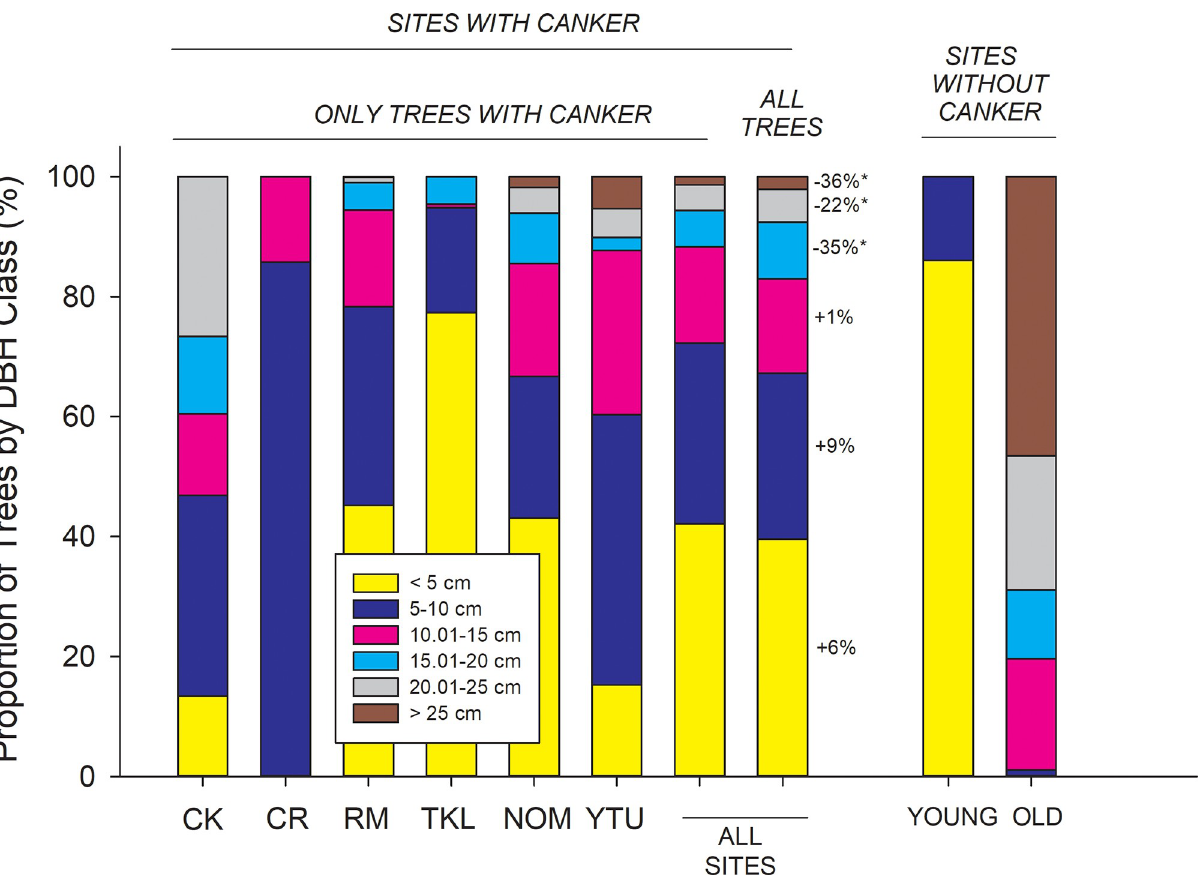
Fig 5. Proportion of DBH size classes at 72 sites with canker (columns 1–8) and at 16 sites without canker (columns 9–10). For sites with canker, the first 6 columns show data for only trees with canker categorized by ecoregion, and column 7 shows the mean across all sites for trees with canker. Column 8 shows the size distribution of all trees (with and without canker) at sites where canker was present. Values beside size classes in Column 8 refer to the % increase in proportion of infected trees vs. the population as a whole for each size class ( � P < 0.10). For example, there are 6% more trees infected with canker in DBH class 1 than there are in the population (NS), while there are 35% fewer trees infected with canker in 15–20 cm size class than there are in the population as a whole (P < 0.10). Columns 9 and 10 show data for sites without canker, broken down into young sites (n = 9) and older sites (n = 7). For sites without canker, young sites (column 9) were located within recent burn perimeters scattered across the Yukon Tanana Uplands, Ray Mountains, and North Ogilvie Mountains ecoregions, while 6 of 7 old sites (column 10) were located south of the Alaska Range within the Cook Inlet and Copper River ecoregions. CK = Cook Inlet, CR = Copper River, RM = Ray Mountains, TKL = Tanana Kuskokwim Lowlands, NOM = North Ogilvie Mountains, YTU = Yukon Tanana